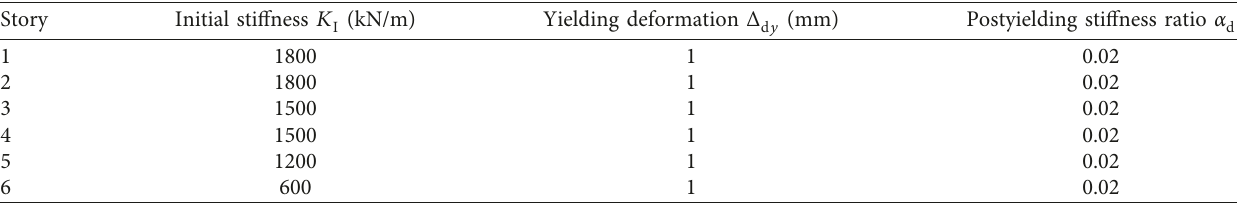
Table 5: Parameters of dampers at each story.